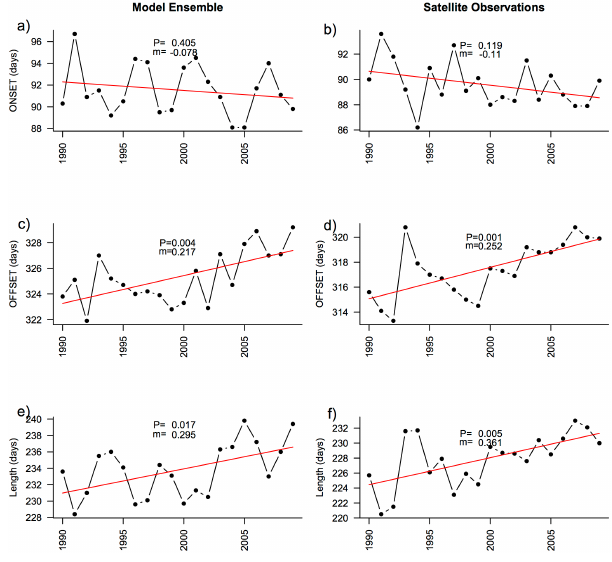
Figure 7. Ensemble-mean trends in the onset (a, b) , offset (c, d) , and length of growing season in days (e, f) for the ensemble mean (left) compared with satellite-derived estimates